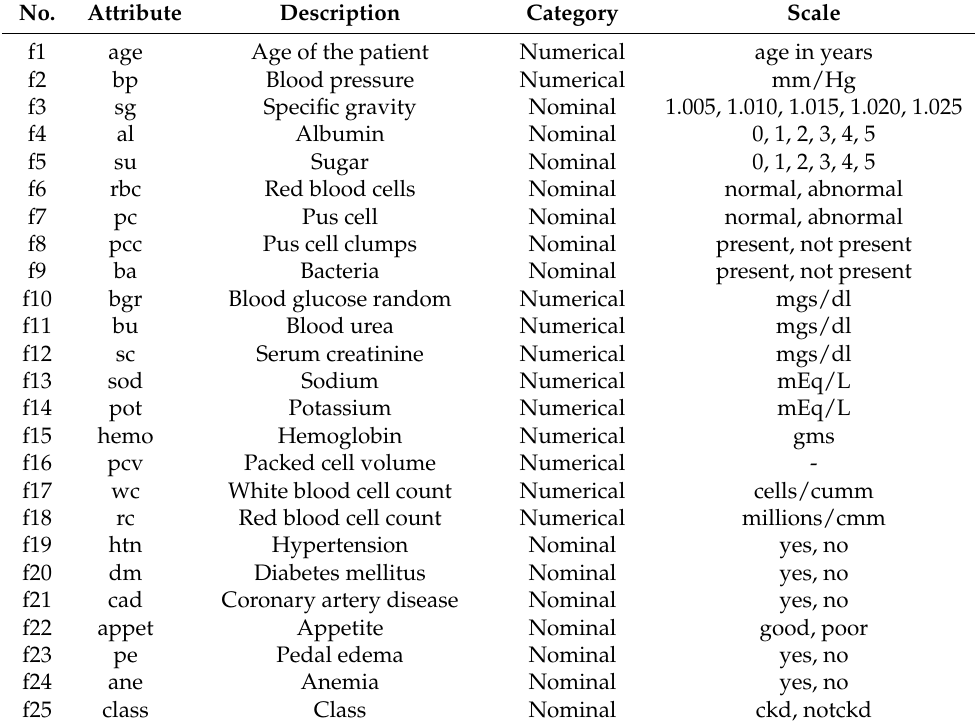
Table 1. CKD dataset